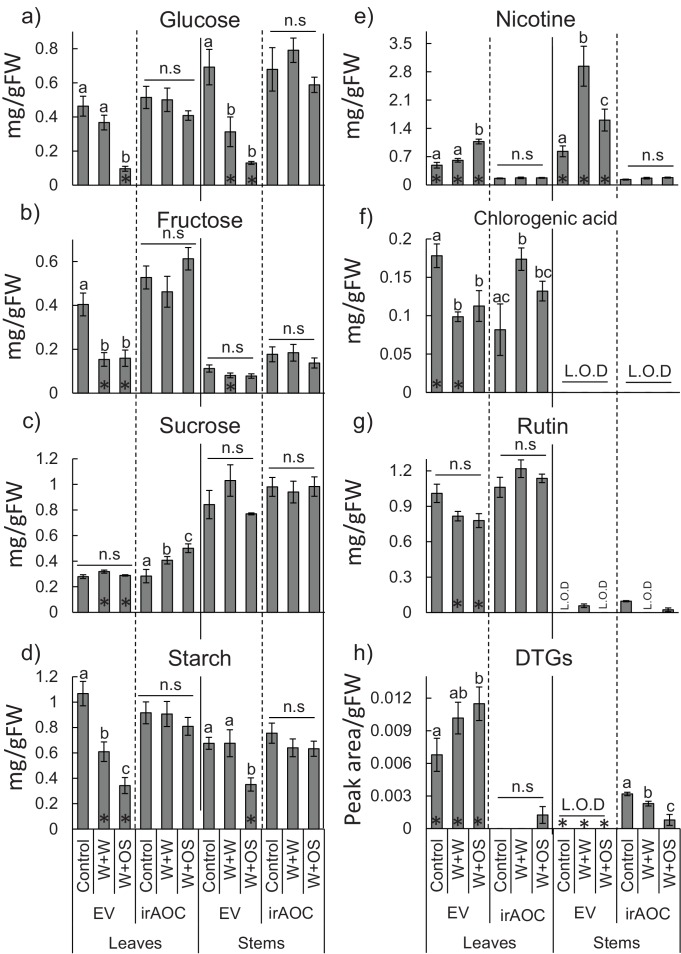
Secondary metabolite profiles in leaves and stems of N. attenuata in response to simulated herbivore attack.Mean (±SE) glucose (a), fructose (b), sucrose (c), starch (d) nicotine (e), chlorogenic acid (f), rutin (g) and diterpene glycosides (DTGs) (h) (n=5). Different letters indicate significant differences between treatments within genotype and tissue (p<0.05). n.s: not significant. Asterisks indicate significant differences between genotypes within treatment (*p<0.05). L.O.D: limit of detection. Control: intact plants; W+W: wounded and water treated plants; W+OS: wounded and M. sexta-oral secretions treated plants.